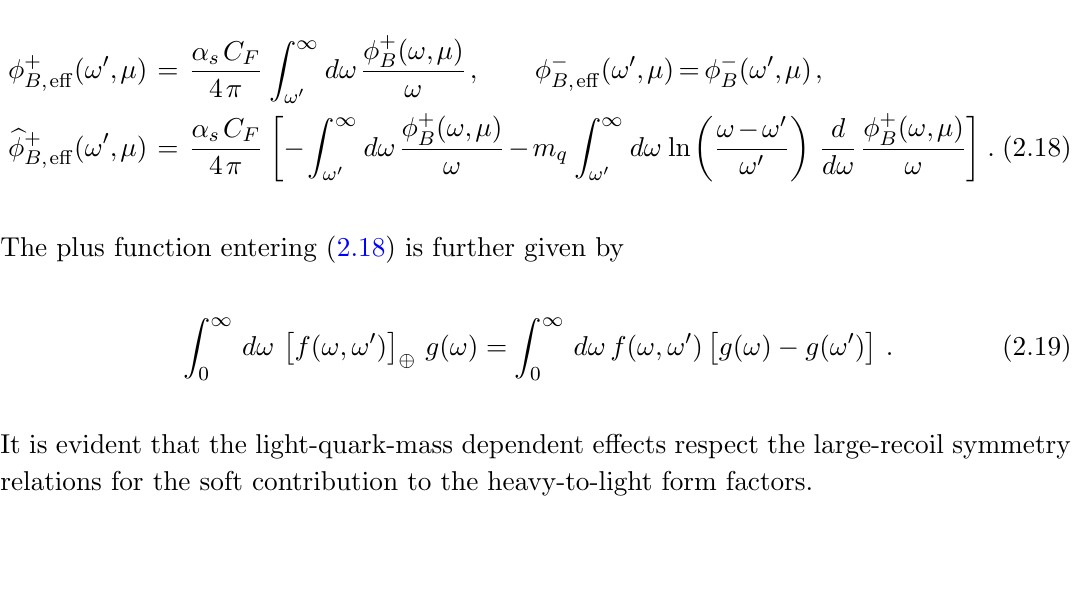
Figure 1 . Diagrammatical representation of the three-particle higher-twist corrections to the vacuum-to- B -meson correlation function (2.1). The square box indicates the insertion of the weak vertex (cid:22) q (cid:0) (cid:22) b , and the waveline represents the interpolating current (cid:22) d=n (cid:13) 5 q for the light-pseudoscalar